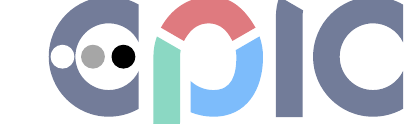
Fig. 1 Logo of the